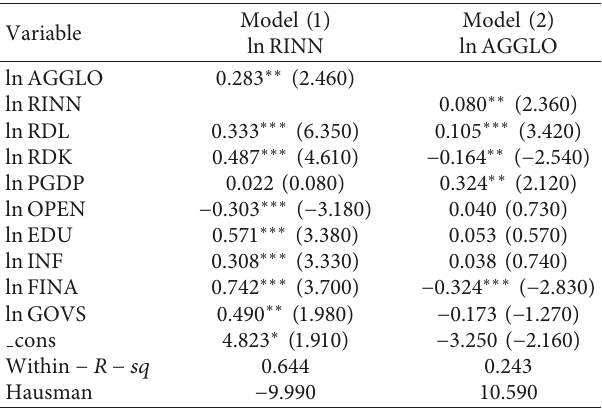
Table 3: Interaction effect test